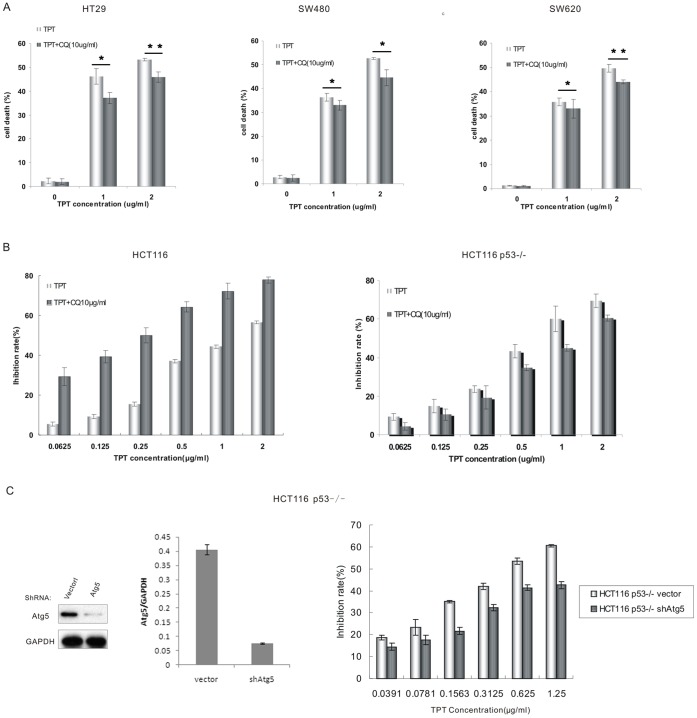
The inhibition of autophagy in p53 mutant cells blocked the cell death induced by topotecan treatment. A.The HT29, SW480, and SW620 cells were incubated with the indicated concentrations of topotecan or a combination of topotecan and 10 µg/mL CQ for 24 h. The amount of cell death was quantified using the PI staining assay by flow cytometry. Data in A are means ± s.d. (n  =  3). *P<0.05,**P<0.01, Student’s t test B. HCT116 p53+/+and HCT116 p53−/− cells were cultured at 6000 cells per well in a 96-well plate and exposed to different concentrations of TPT (0.0625 to 2 µg/mL) and/or 10 µg/mL CQ for 72 h. The level of growth inhibition was detected using the MTT assay. C. Lysates from HCT116 p53−/− cells transfected with the vector or Atg5 shRNA were analysed by immunoblotting. The MTT assay was used to analyse the level of cell growth inhibition. Data in B,C are means ± s.d. (n  =  3). P<0.05, Student’s t test.